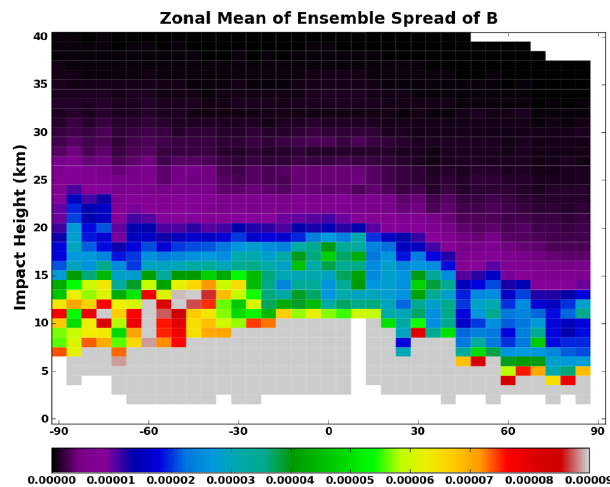
Figure 6. Zonal mean of ensemble spread in the bending-angle ob- servation space (unit: rad) at the initial time of EXP_RO at 00Z of 15 November 2011, which is from